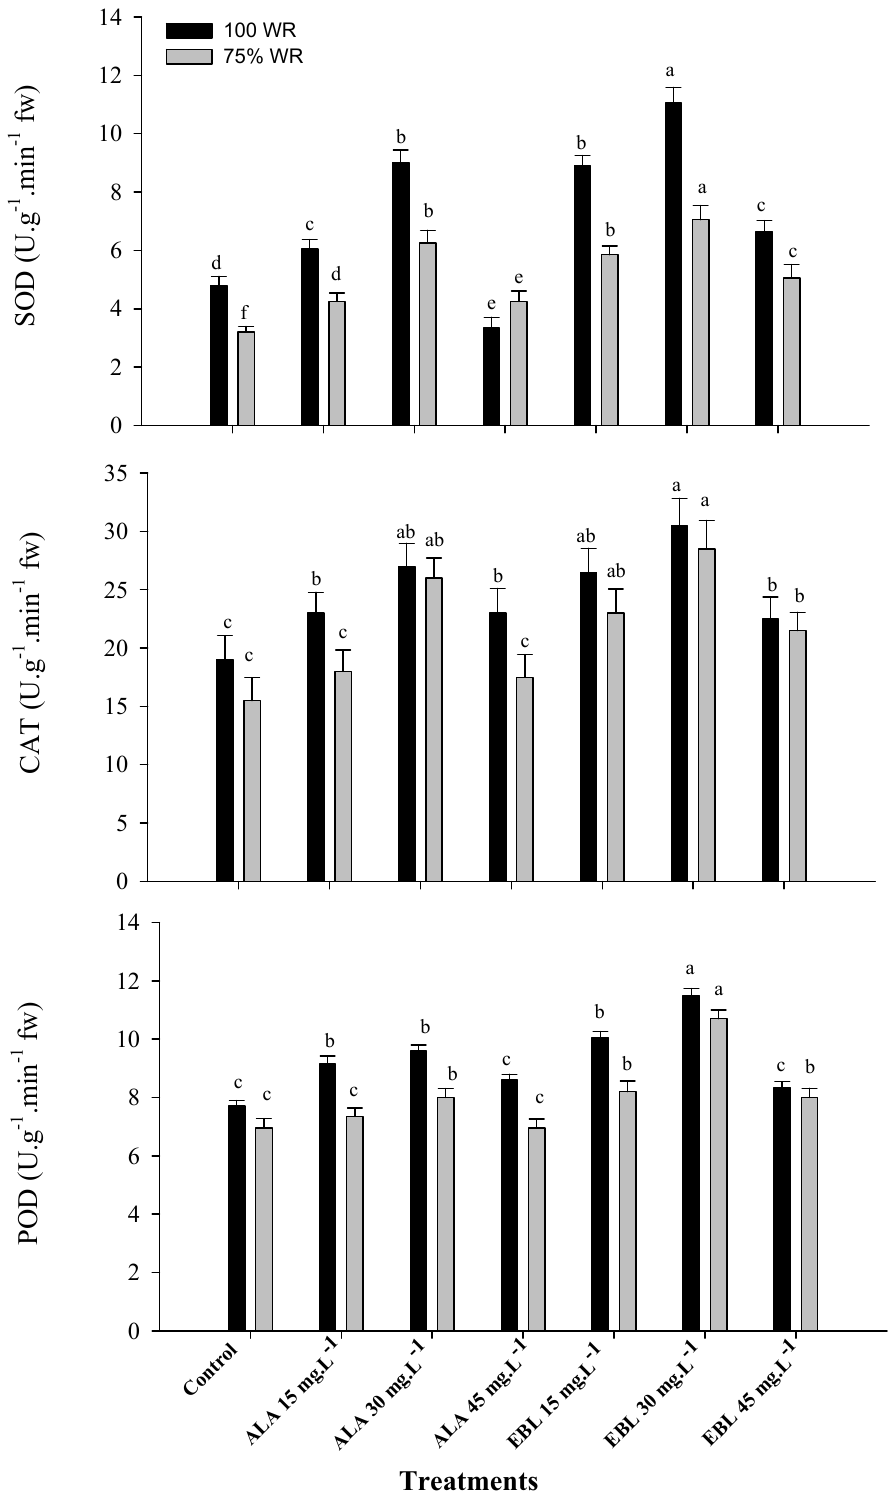
Figure 3. Effect of foliar spray with ALA or EBL on the activity of superoxide dismutase (SOD), catalase (CAT), and peroxidase (POD) in drought-stressed “Williams” banana plants during the 2018/2019 and 2019/2020 seasons ( n = 5). The results are the averages of both seasons, and DMRT was used for mean comparisons of treatments under each WR level ( p ≤ 0.05).